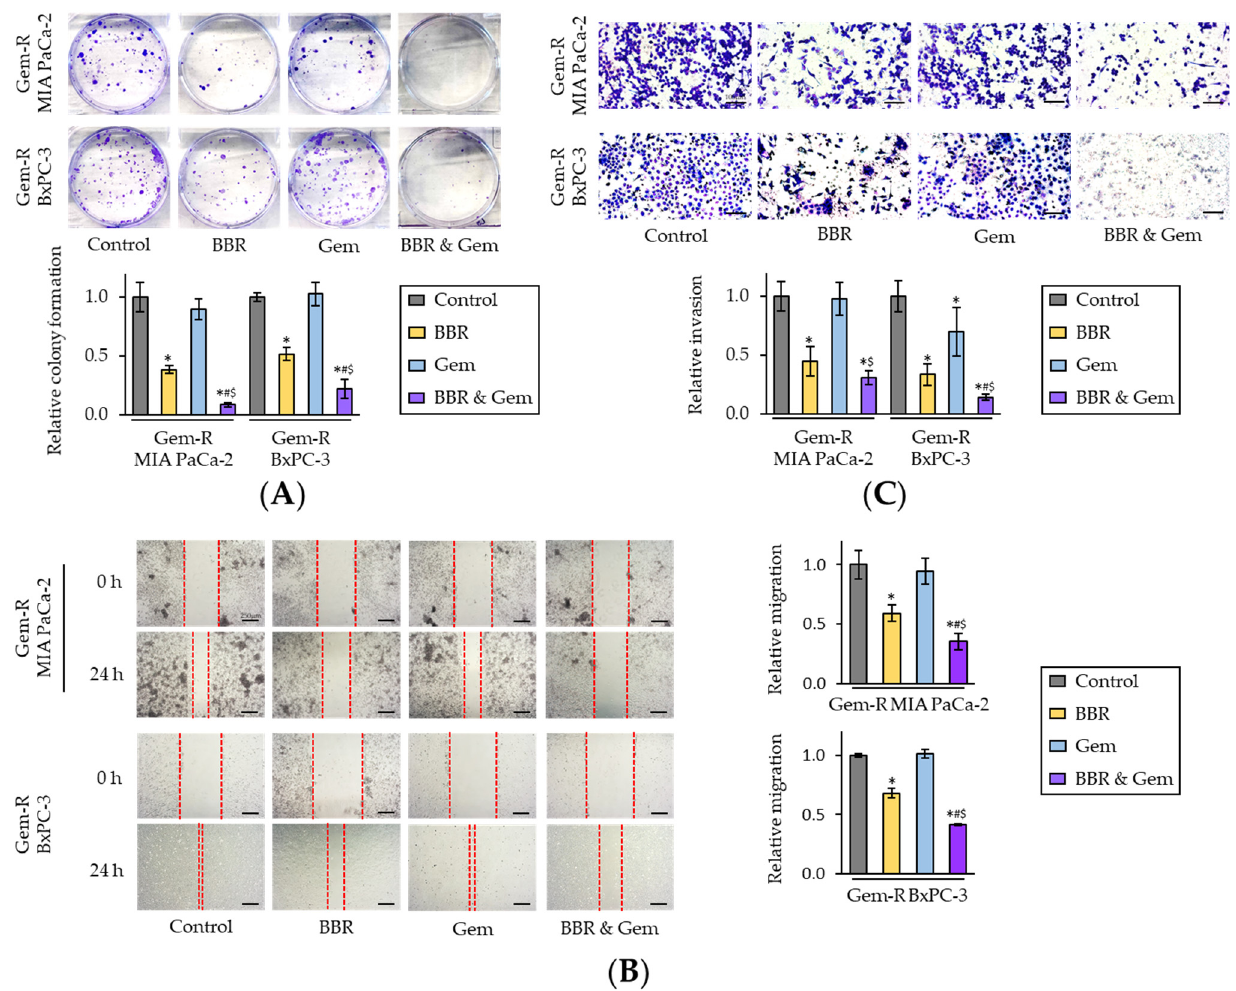
Figure 2. Berberine enhances the chemosensitivity of Gemcitabine-resistant PDAC cells by inhibiting colony formation, migration, and invasion. ( A ) Colony formation assays of Gem-R PDAC cells following treatment. The average (column) ± SD is indicated (* p < 0.05 vs. control, # p < 0.05 vs. BBR, $ p < 0.05 vs. Gem); ( B ) Wound healing assays following in Gem-R PDAC cells. Images show representative areas (marked by red lines). Scale bar = 250 μ m. The average (column) ± SD is indicated (* p < 0.05 vs. control, # p < 0.05 vs. BBR, $ p < 0.05 vs. Gem); ( C ) Invasion assays following treatment in Gem-R PDAC cells. Scale bar = 100 μ m. The number of cells was randomly counted at four fields, and then relative invasion ratios were calculated. The average (column) ± SD is indicated (* p < 0.05 vs. control, # p < 0.05 vs. BBR, $ p < 0.05 vs. Gem). Images show representative fields on the membrane (magnification x100). Gem-R, Gemcitabine-resistant; PDAC, pancreatic ductal adenocarcinoma; BBR, Berberine; Gem, Gemcitabine; SD, standard deviation.